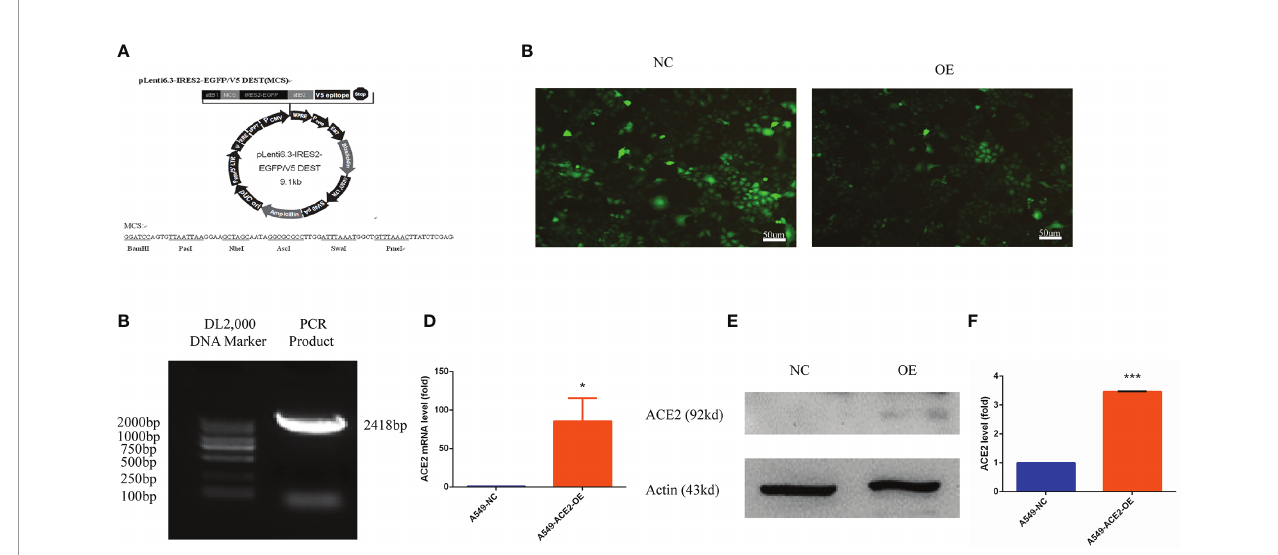
FIGURE 3 | Human ACE2 was stably overexpressed in A549-ACE2-OE cells. (A) Schematic representation of pLenti6.3-MCS/V5 DEST. (B) pLenti6.3-ACE2 expression vector was detected by PCR. (C) Fluorescence of EGFP in A549-ACE2-OE cells (left) and parental cells (right) was determined by fl uorescence microscopy. (D) RT-PCR experiment of ACE2 mRNA level in A549-ACE2-OE cells and control cells, Mean ± SD, n = 3, *p < 0.05. (E) Western blot analysis of ACE2 expression level in A549-ACE2-OE cells and parental cells. (F) Quanti fi cation of ACE2 expression level in A549-ACE2-OE cells and parental cells. Mean ± SD, n = 3, ***p < 0.001.